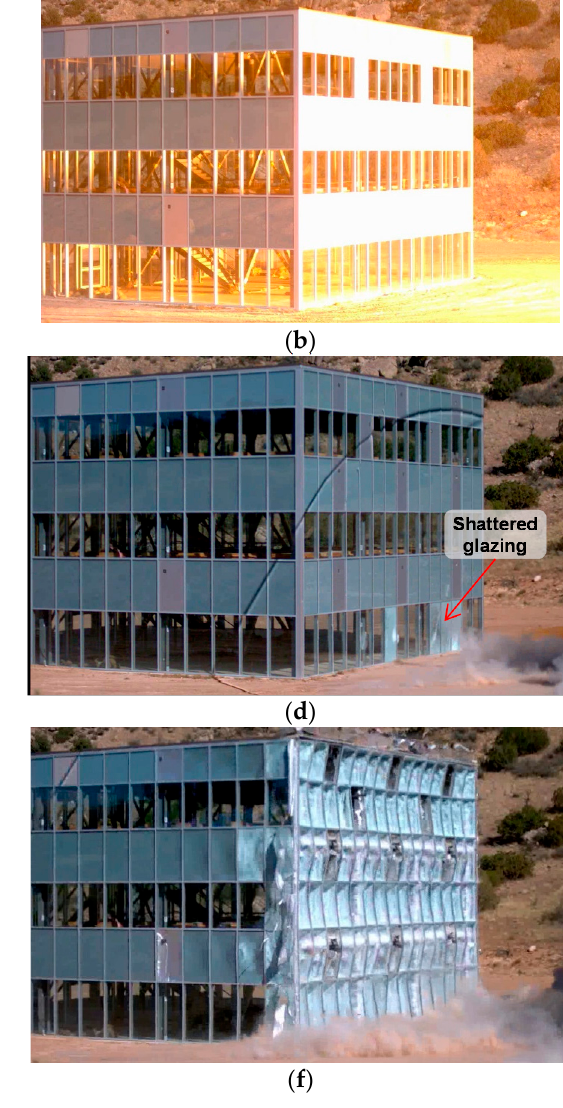
Figure 12. Test 1—Snapshots from high-speed video footage during test: ( a ) Prior to detonation; ( b ) Explosive charge detonation; ( c ) Arrival of shock wave; ( d ) Initial glazing failure on first floor; ( e ) Completely shattered glazing on front elevation; ( f ) Façade damage propagates to side façade.